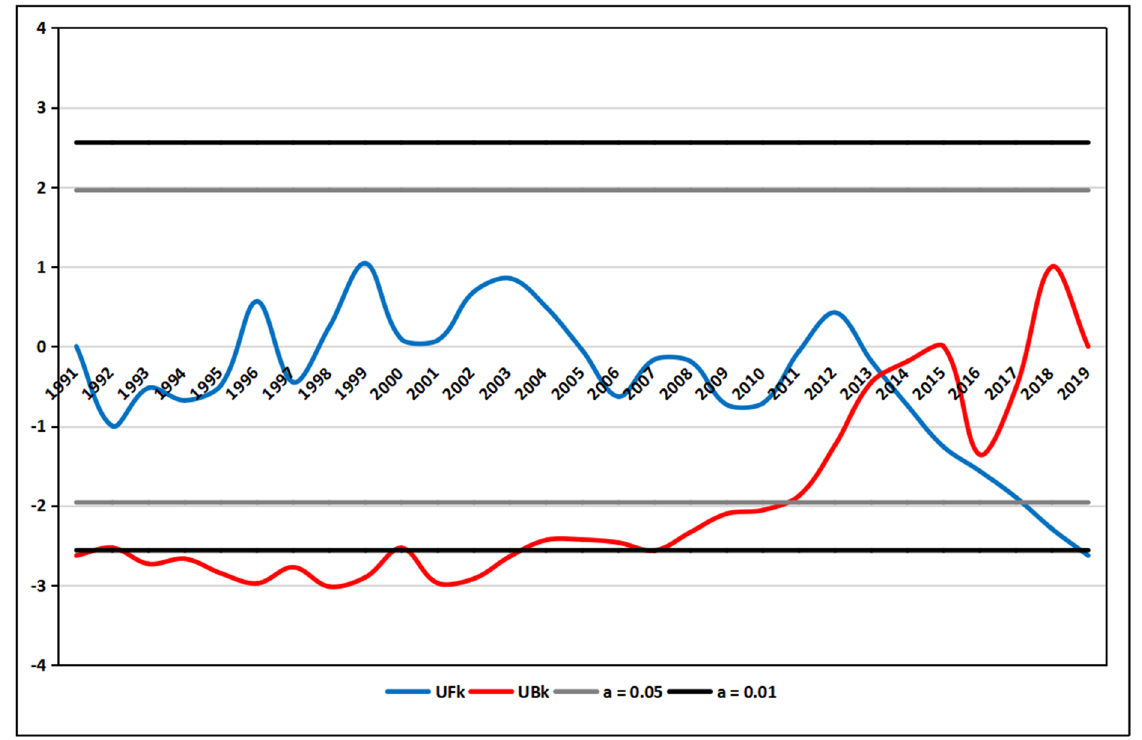
Figure 14. M–K abrupt-change test results for F TSM in the Padma River. The blue UF k curve and red UB k curve signify the sequential and reversed time series for F TSM , respectively. The critical values for the significance levels a = 0.05 and 0.01 ( U 0.05 and U 0.01 , respectively) are ±1.96 and ± 2.32, respectively.